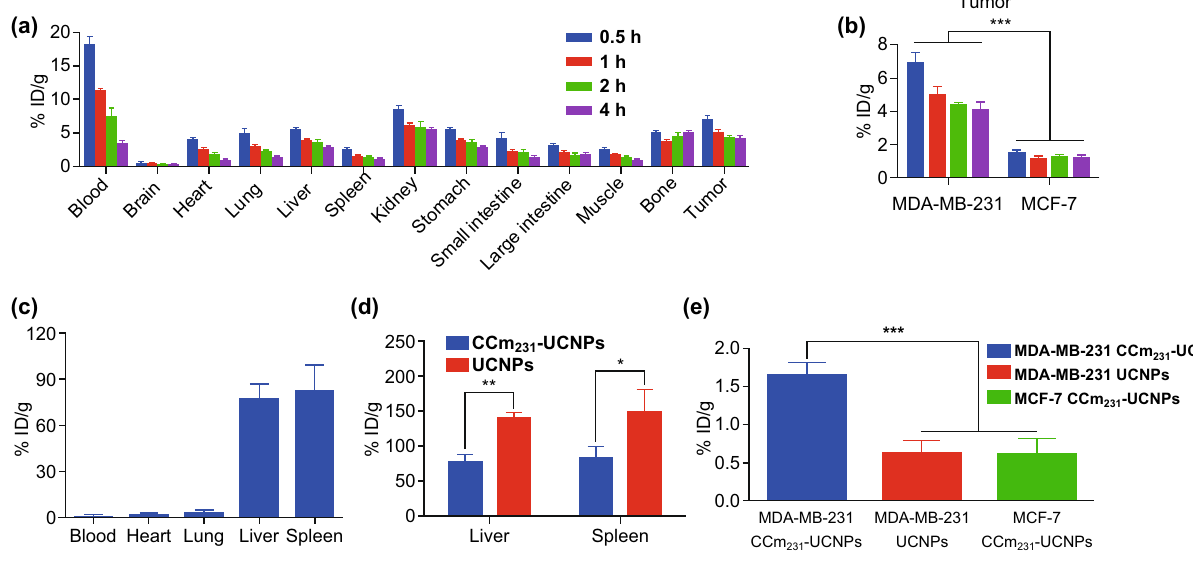
Fig. 4 a Biodistribution of 18 F in different organs and tumors in MDA‑MB‑231 tumor‑bearing mice at different times after the injection. b Tumor uptake of 18 F comparing in MDA‑MB‑231 and MCF‑7 tumor‑bearing mice. Biodistribution of Gd 3+ in different organs, tissues, and tumors. c CCm 231 ‑UCNPs in the blood, heart, lung, liver, and spleen. d CCm 231 ‑UCNPs and UCNPs in the liver and spleen. e Tumor uptake of Gd 3+ in the MDA‑MB‑231